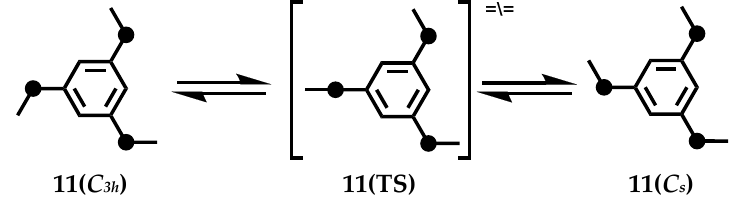
Figure 8. Bridge flipping process and stable conformers of [3 3 ](1,3,5)CP 11 .